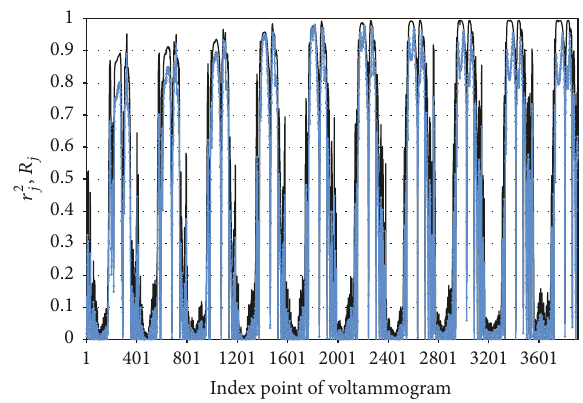
Figure 2: Squared coefficient of correlation-for-suppressor- concentration ( 𝑟 2 ) (solid black line) and SIMCA modeling power (𝑅) (𝐹 = 1) (solid blue line with diamonds) calculated for entire voltammograms of waveform presented in Figure